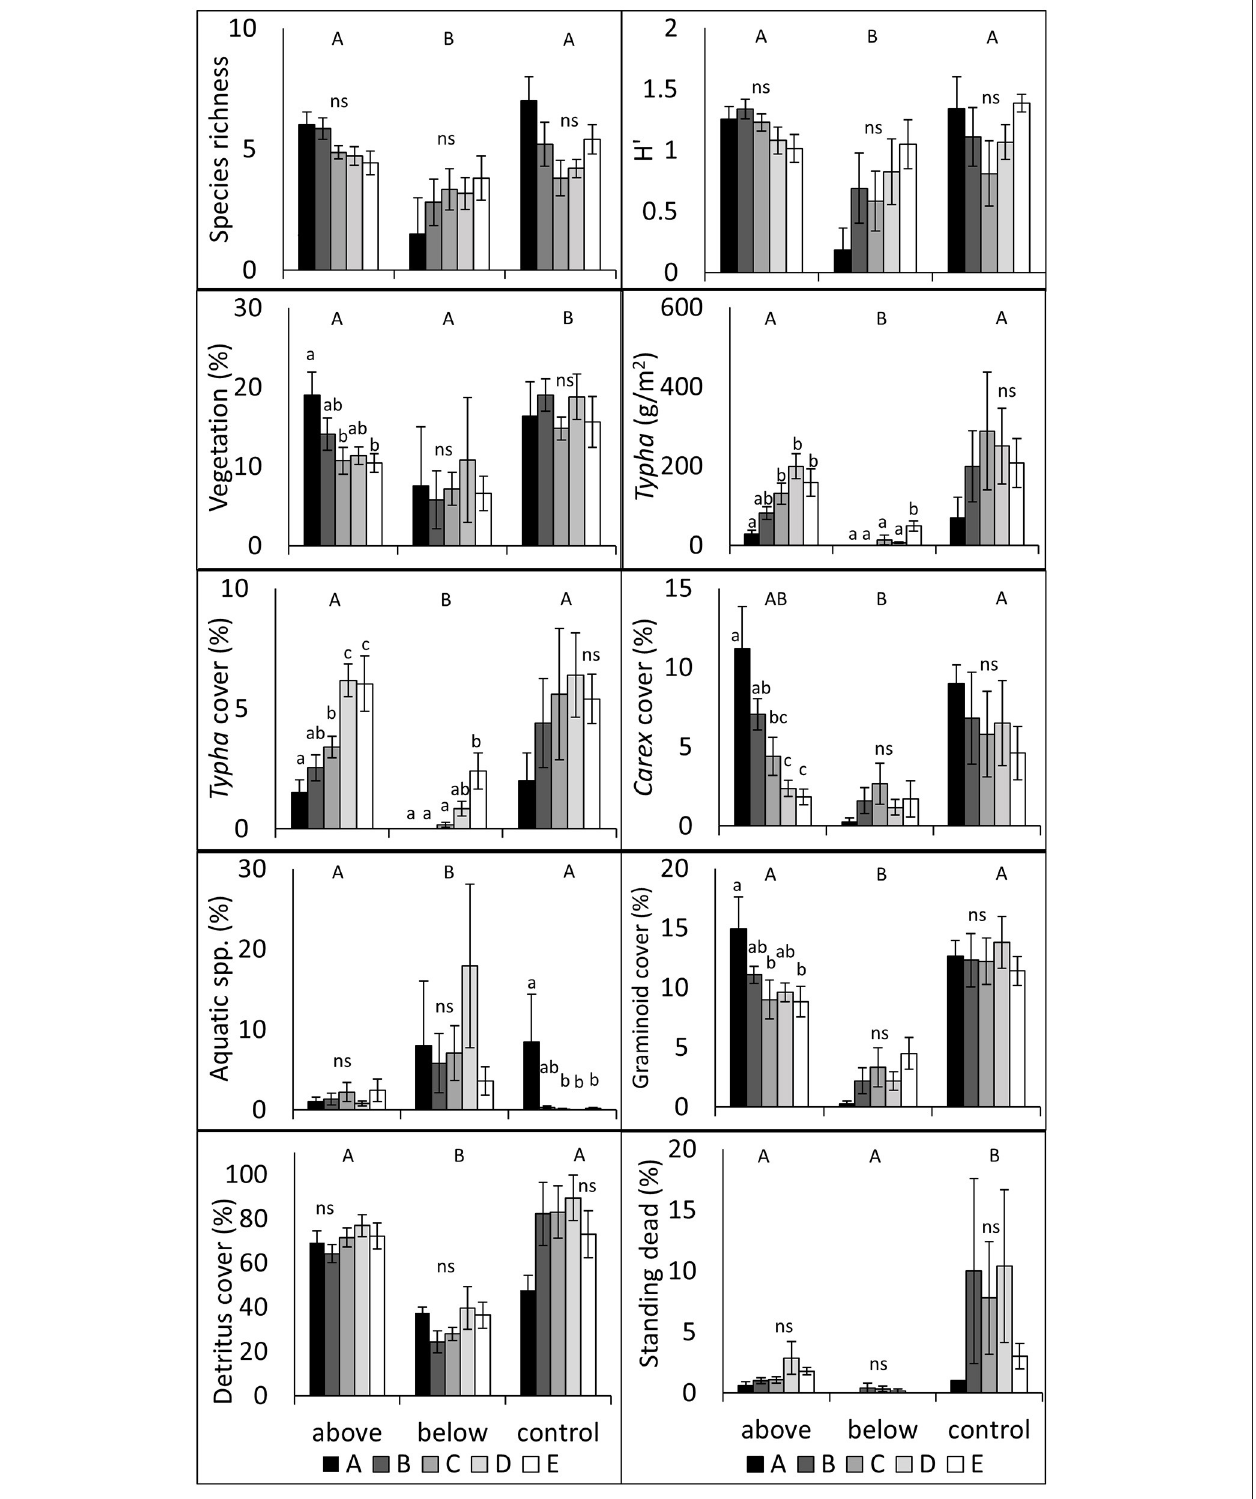
FIGURE 3 | Vegetation responses by treatment and subplot ± SE in 2016, 1-year following treatment implementation. Capital letters denote significant treatment contrasts; lowercase letters denote within treatment subplot contrasts; ns denotes no significant differences ( P > 0.05) between subplots. Subplots approach the center of each stand with alphabetically increasing